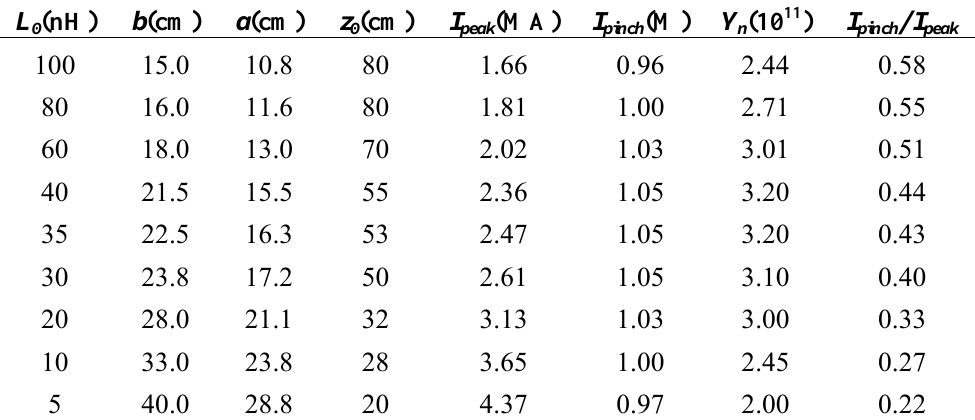
Table 1. Effect on currents and ratio of currents as L 3.5 Torr Deuterium.